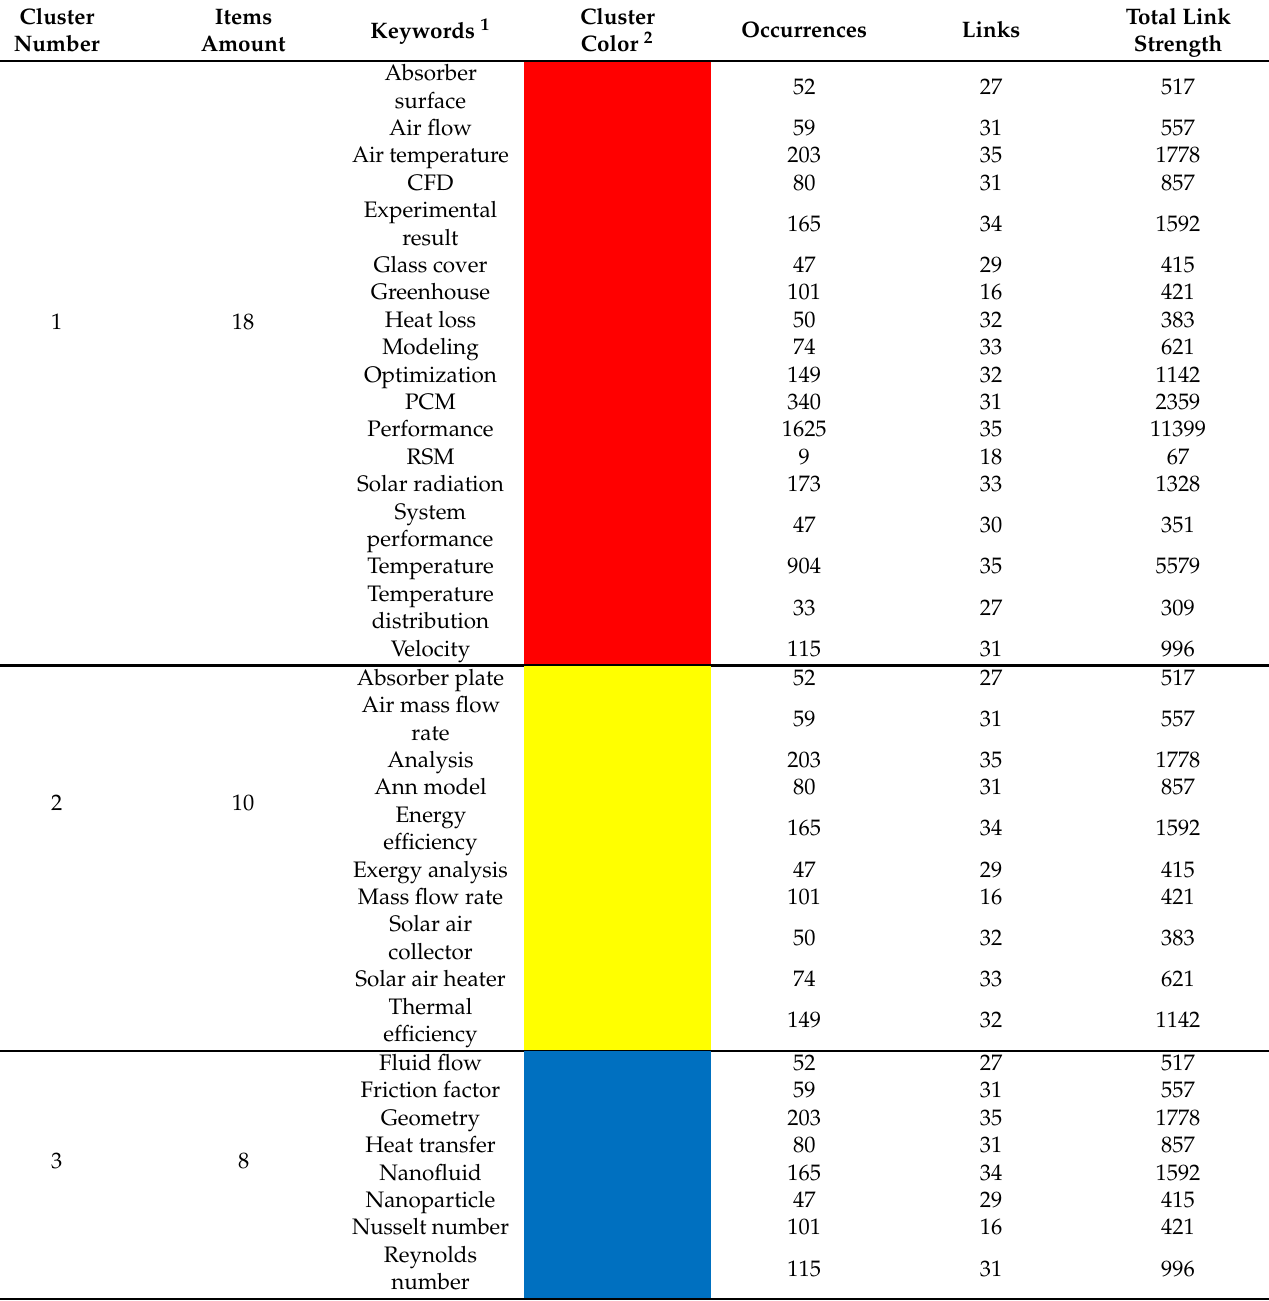
Table 1. Solar air heaters keywords bibliometric network